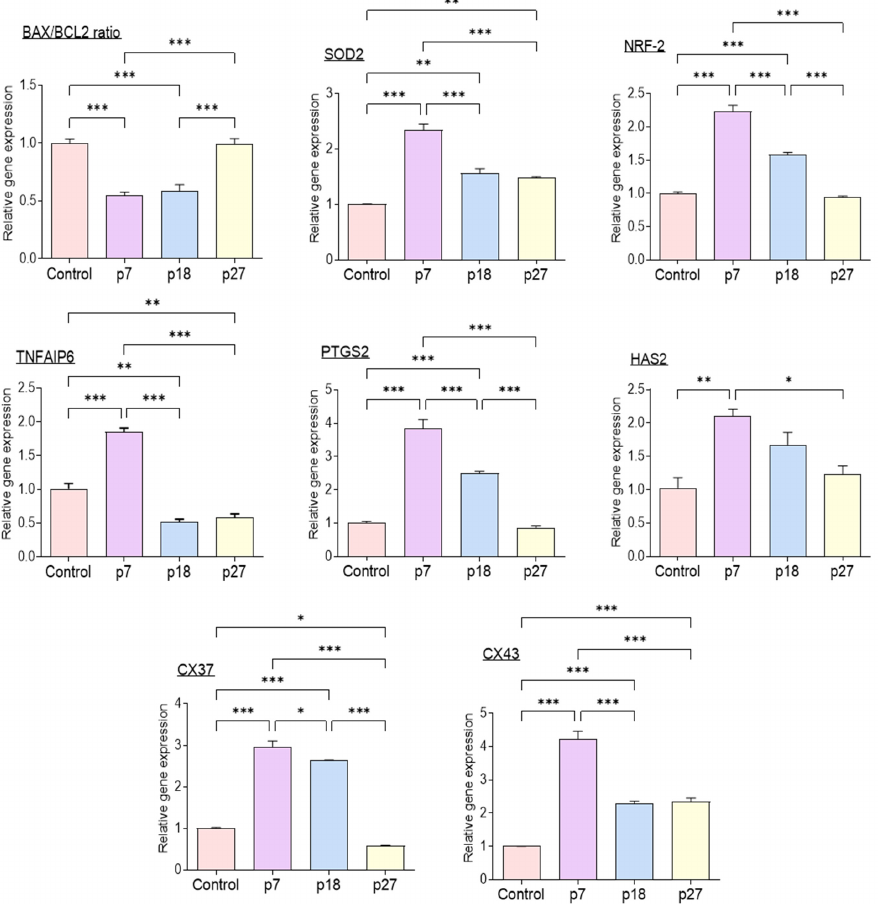
Figure 2. Relative expression of apoptosis-related genes (BAX, BCL2), antioxidant enzyme relative genes (SOD2 and Nrf-2), cumulus expansion related genes (HAS2, TNFAIP6 and PTGS2), and cumulus gap junction related genes (Cx37 and Cx43) in porcine cumulus cells. The asterisks represent significantly different when compared to the control (*: p < 0.05, **: p < 0.01, ***: p < 0.001,). Scale bar = 100 μ m. Bax; BCL2 Associated X, Bcl2; B-cell lymphoma 2, HAS2; hyaluronan synthase 2, TNFAIP6; tumor necrosis factor α -induced protein 6, PTGS2; prostaglandin-endoperoxide synthase 2, Nrf-2; nuclear factor erythroid 2–related factor 2, SOD2; Superoxide dismutase 2, CX37; Connexin 37, CX43; Connexin 43.